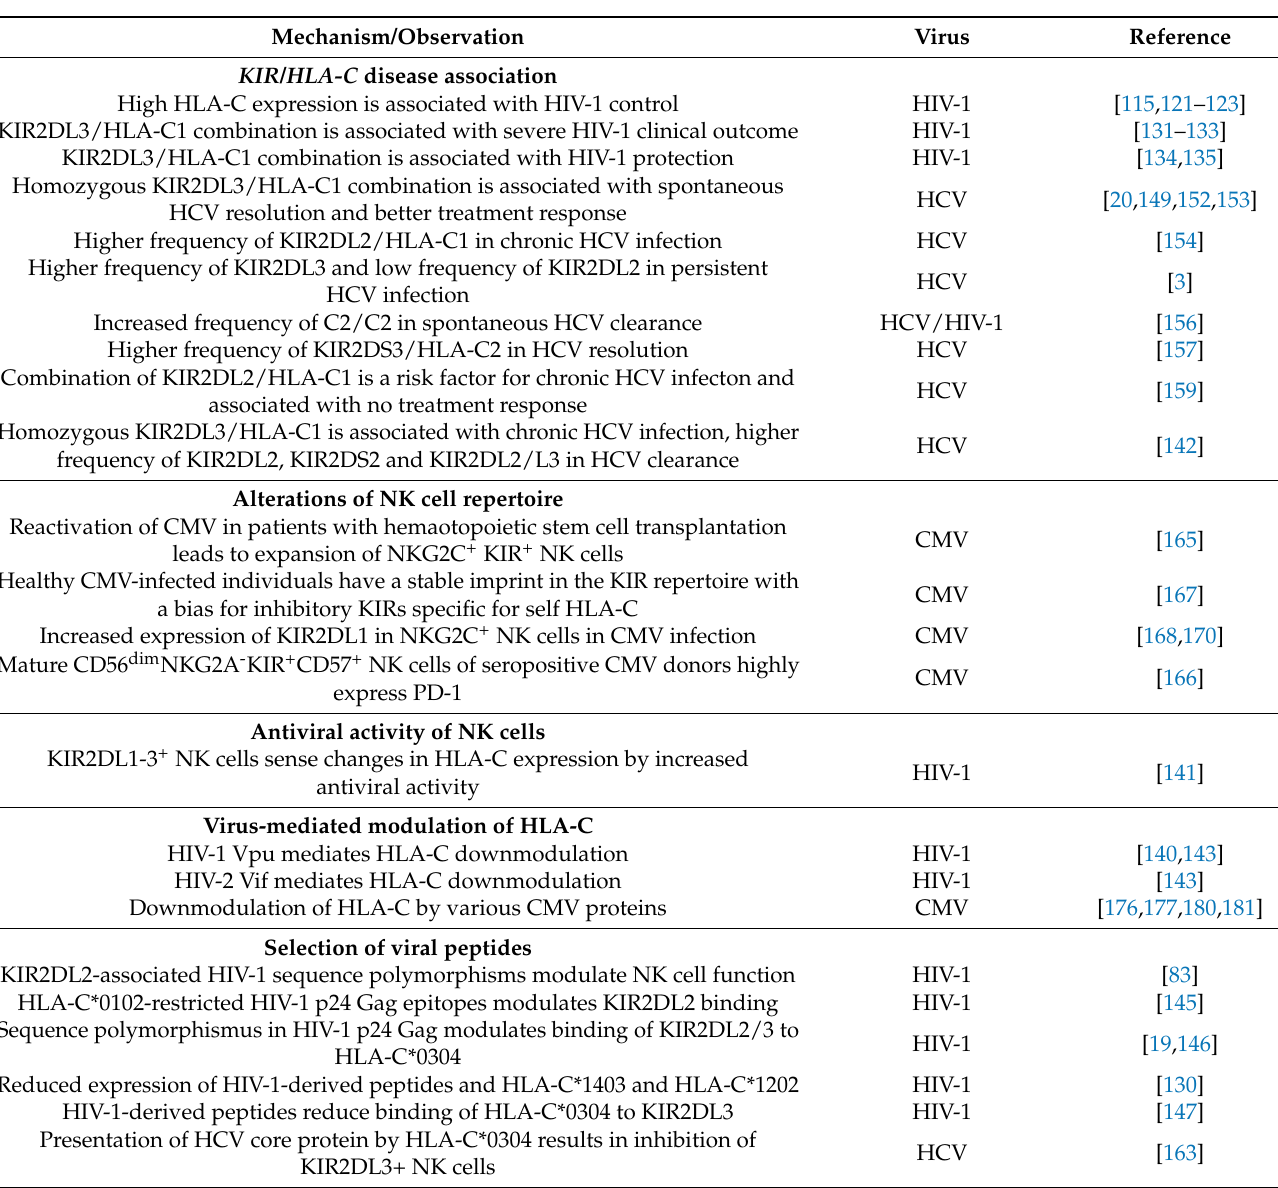
Table 2. HLA-C-mediated impact in HIV-1, HCV and CMV